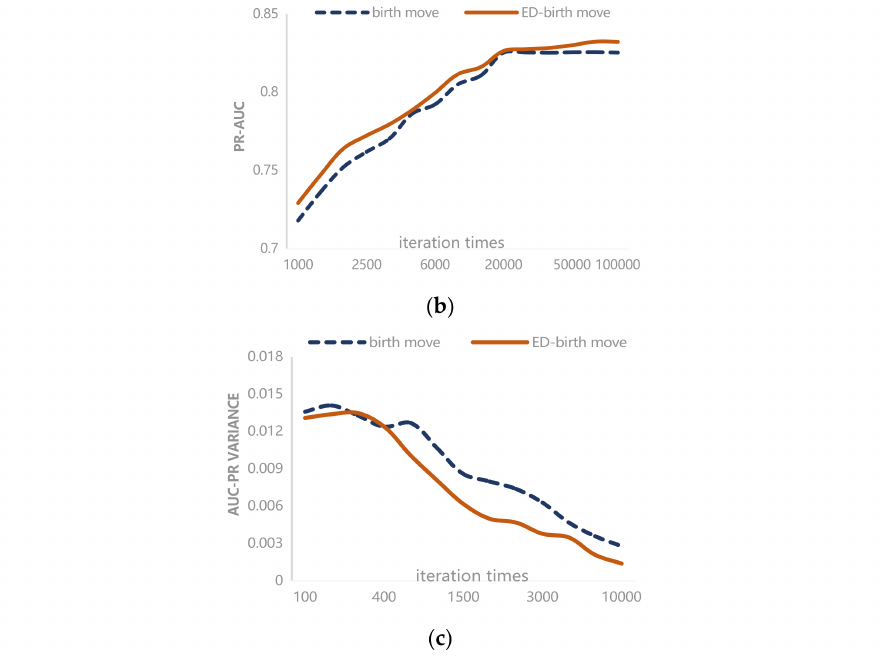
Figure 8. PR-AUC and variance under different models. Panel ( a ) shows the network reconstruction accuracy in terms of PR-AUC scores incorporating the proposed ED-birth into the Globally Coupled NH-DBN and EWC NH-DBN. Panel ( b ) shows the relationship between the network reconstruction accuracy in terms of PR-AUC and the number of MCMC iterations under Globally Coupled NH-DBN. Panel ( c ) shows model stability in terms of PR-AUC variance under globally coupled NH-DBN.